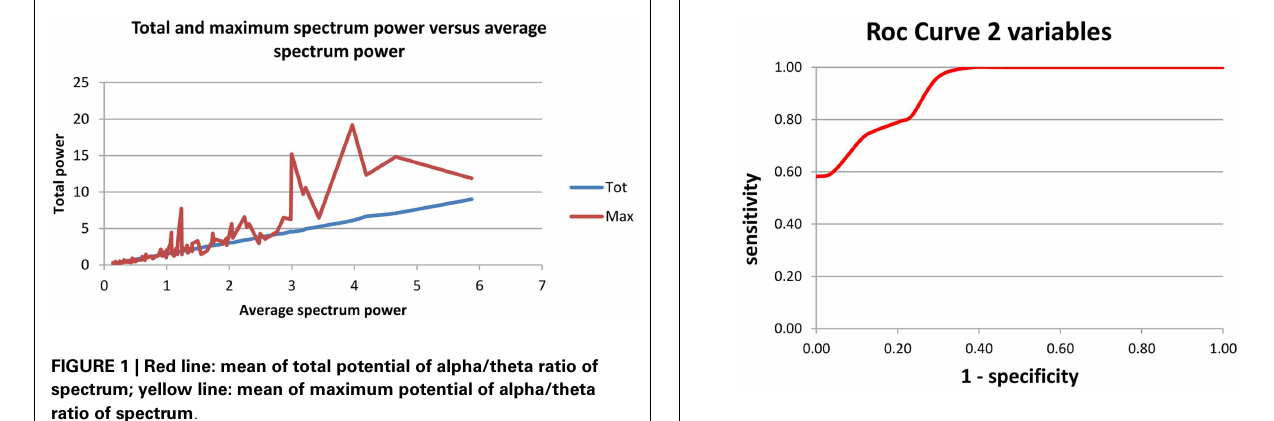
FIGURE 3 | Index 2 – using a double variable – the alpha/theta ratio of the mean potential of the O1 and C3 electrodes; a: sensitivity and b: specificity